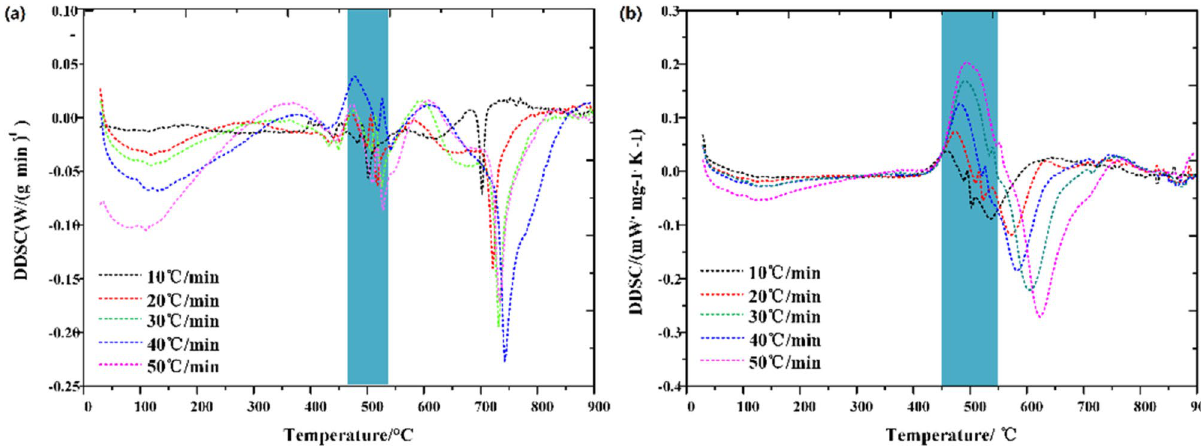
Figure 13. DDSC curve of Huadian oil shale ( a ) N 2 ( b ) CO 2 .